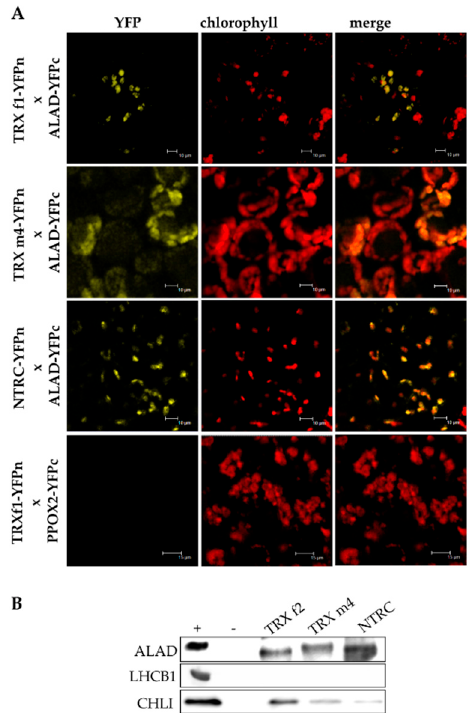
Figure 4. The physical interaction between ALAD and NTRC, TRX f1 and TRX m4. The interaction between ALAD and different thioredoxin (TRX) variants was demonstrated by bimolecular complementation assay (BiFC) ( A ) or a pulldown assay ( B ). ( A ) Nicotiana benthamiana leaves were infiltrated with Agrobacterium tumefaciens strains. After two days of transient expression of the transgenic gene constructs, images were taken by laser scanning fluorescence microscopy. Left row: YFP; middle row: autofluorescence of the chlorophyll; right: merge. PPOX2 and TRX f2 expression did not lead to mutual protein–protein interaction and was used as a negative control for the BiFC experiment. ( B ) The recombinant, His-tagged bait proteins TRX f2, TRX m4, NTRC were incubated with chloroplast extract. Proteins in the eluate were detected by immune analysis using antibodies against ALAD, LHCB1 and CHLI. The chloroplast extract served as a positive control (+). For the negative control, the pulldown assay was performed with Ni-NTA agarose, lacking the binding of a bait protein ( − ).